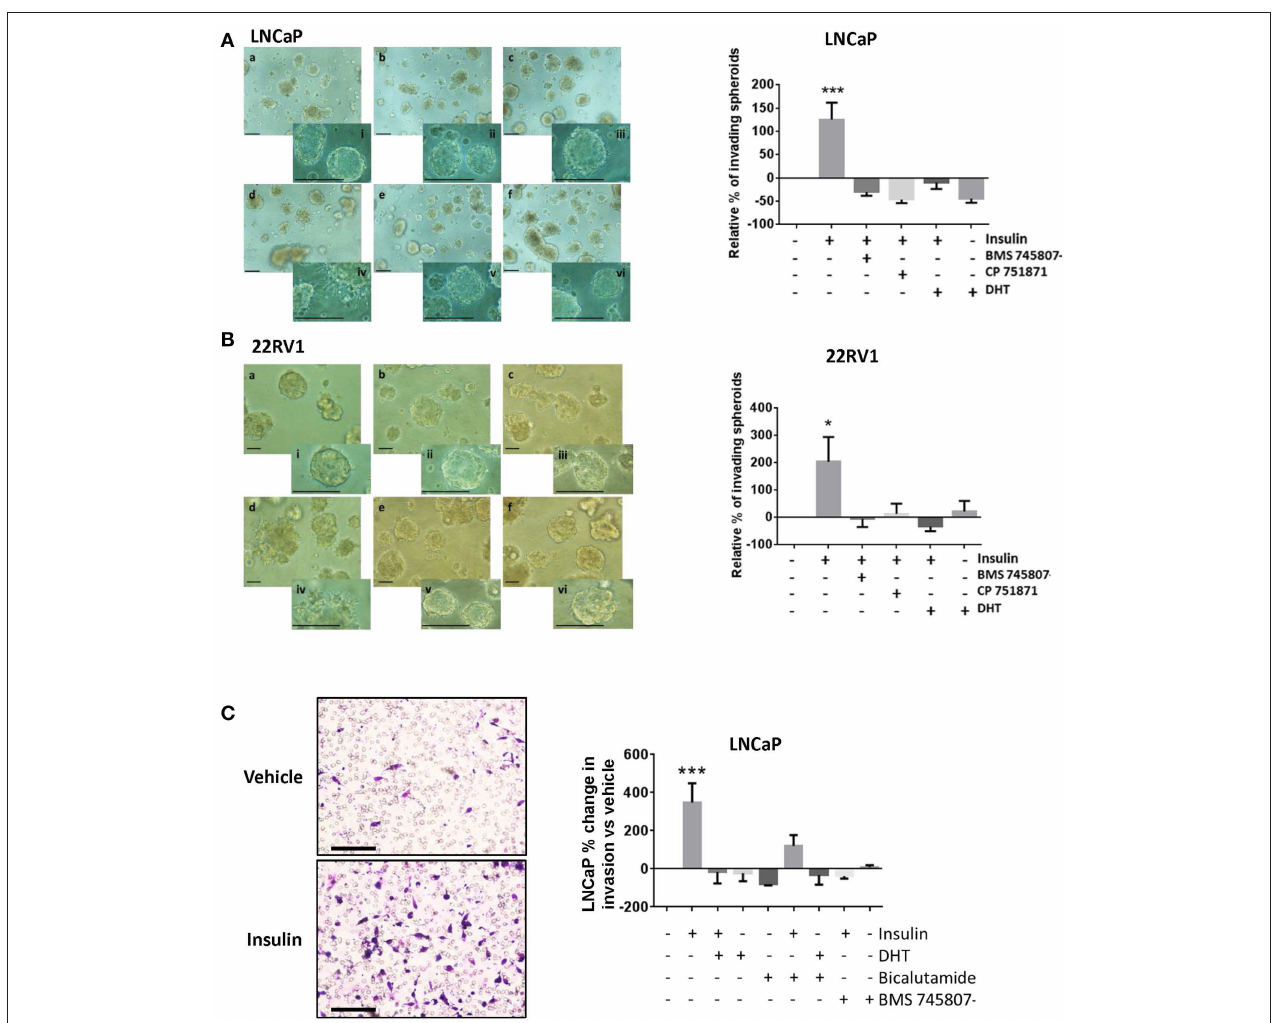
FIGURE 3 | Insulin induced invasion in PCa cells. Quantitation of spheroid growth in 3D Matrigel TM assay following treatment with (a) Vehicle (CSS), (b) insulin + BMS 745807, (c) insulin + DHT (d) insulin, (e) insulin + CP 751871 (f) DHT. Scale bars = 100 µ m in image and inset). Insulin (d) promoted spheroid sprouting and invasion in LNCaP cells (A) and 22RV1 cells (B) , which was blocked with CP 751871 (e) and BMS 745807 (b). Images show degree of sprouting after 3 days of insulin treatment, quantitated in the histogram. Sprouting was not observed in vehicle-treated cells (a) at the same time point. DHT-treated cells showed no evidence of sprouting over this time (f). (C) Insulin promoted cell invasion through Matrigel TM coated transwell. The histogram shows addition of DHT completely prevented cell invasion and bicalutamide failed to reverse the inhibitory effect of DHT. BMS 745807 also inhibited insulin induced transwell invasion (All graphs n = 3, * p < 0.05, *** p < 0.001, One-way ANOVA, ± SEM with vehicle as